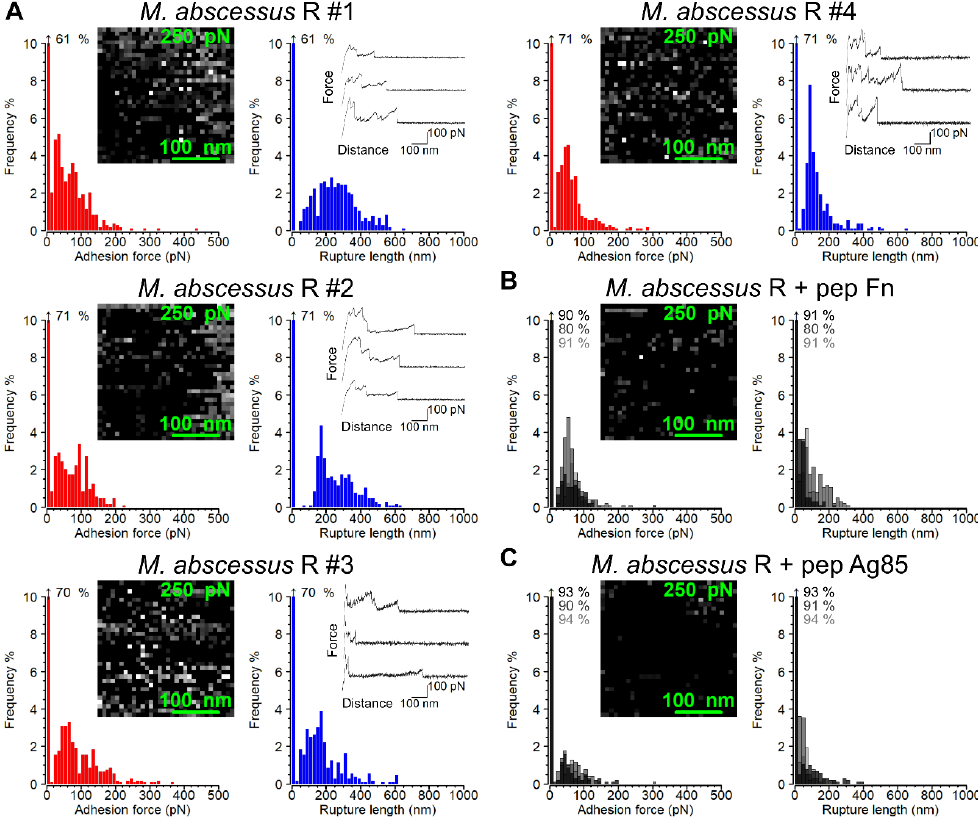
Figure 3. Single Fn-molecule binding to Ag85 on the surface of M. abscessus R cells. ( A ) Adhesion force histograms (left) and maps (inset) as well as rupture length histograms (right) and three representative force-distance curves originating from the same dataset for four M. abscessus R cells. ( B ) Injection of the Fn peptide resulted in significant decreases in Ag85-Fn binding events across the cell surface. Adhesion force histogram plots from three cells were overlaid. ( C ) Injection of the Ag85 peptide resulted in even greater decreases in Ag85-Fn binding events. In the adhesion maps the z-scale, depicting adhesion force in greyscale, ranges from 0 to 250 pN. Data shown are representative of at least 6 untreated or peptide-treated cells.